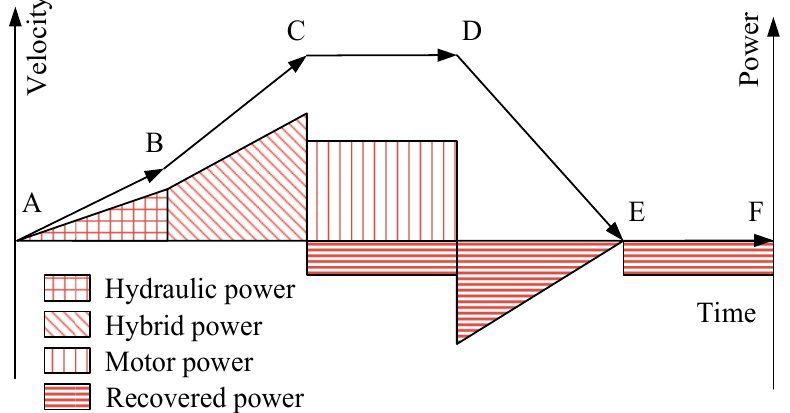
Figure 4. Working mode diagram of the MEH-DCDS. Energies 2020 , 13 , 6279